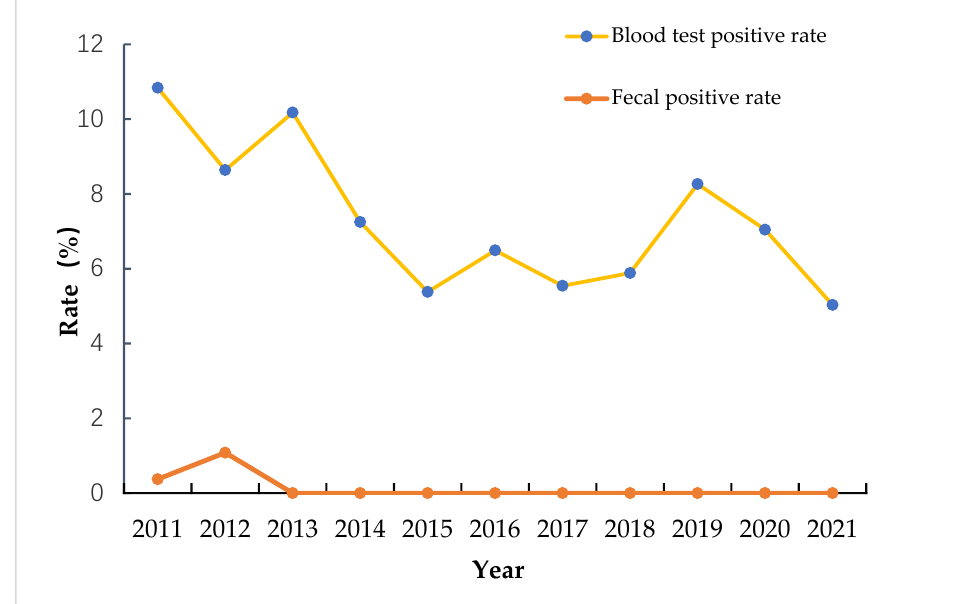
Figure 2. Schistosomiasis infections among people in wetland park areas. The 95%CI of the blood test positive rate: [6.01048825683718, 8.63441466482174].